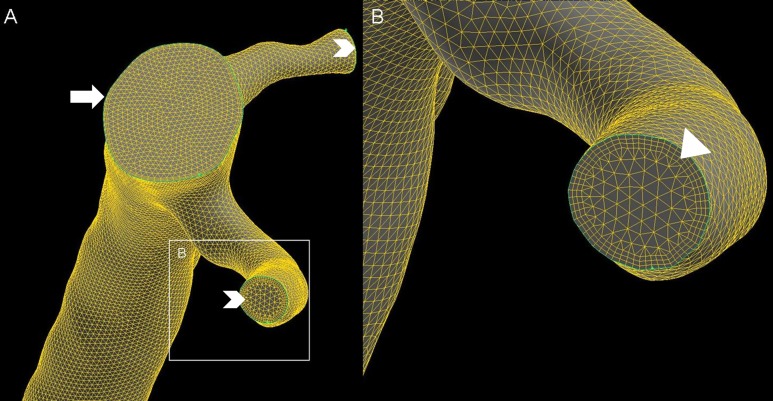
Three dimensional mesh model of a right coronary artery.Panel (A) shows the inflow (arrow) at the ostium of a right coronary artery and outflows of two small side branches (chevrons). Panel (B) shows a magnification of the outflow shown in panel (A). Notice the three boundary layers with small cell size (arrow head), necessary to accurately calculate ESS. Towards the inner lumen of the vessel, cell size increases to reduce the total number of cells and thus computation time.